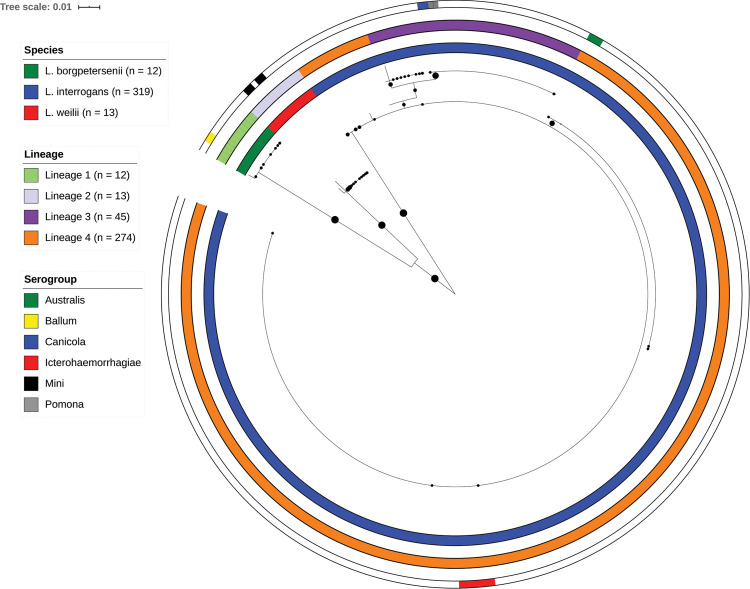
Maximum likelihood phylogeny (1000 bootstrap replicates) of Leptospira secY sequences from patients.The phylogeny shows the distribution of species lineages, and serogroups circulating in FP during the time span from 2002 to 2019 (n = 344). Bootstrap values are shown with the size of circles in the middle of the branches, bootstraps lower than 70 are not shown. Species, lineage and serogroup names are given by the color codes (from inner to outer circles). Serogrouping was performed on culture isolates. White color indicates that the information was not available.